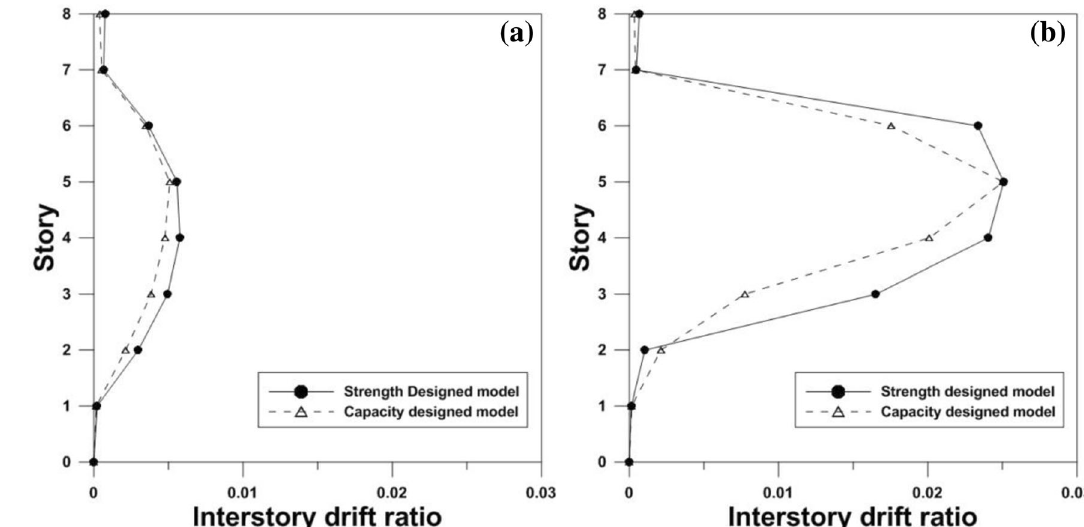
Fig. 15 Maximum inter-story drift ratio of the model structures obtained from pushover analysis. a At maximum strength and b at maximum inter-story drift of